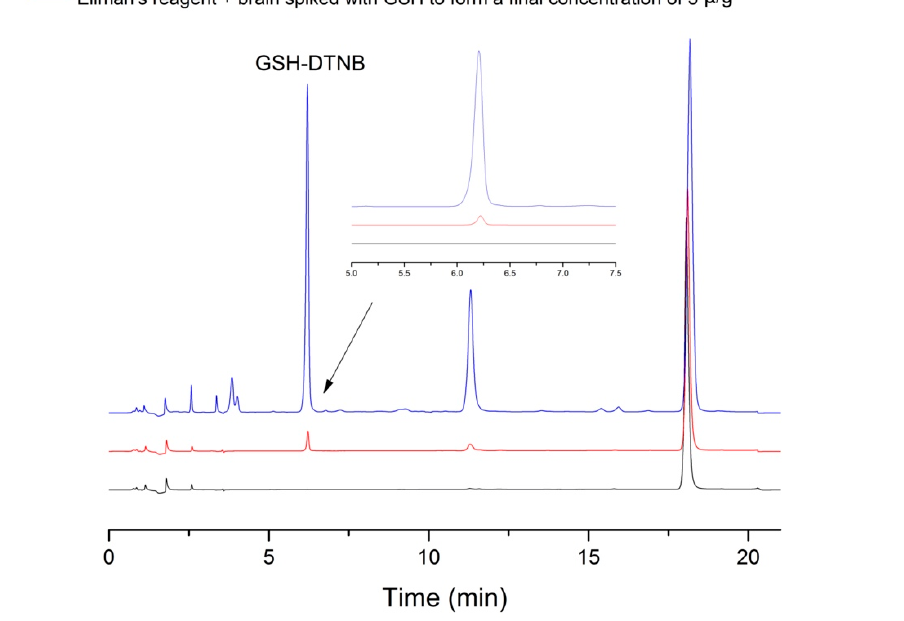
Figure 3. Representative chromatograms of a spiked rat brain sample.